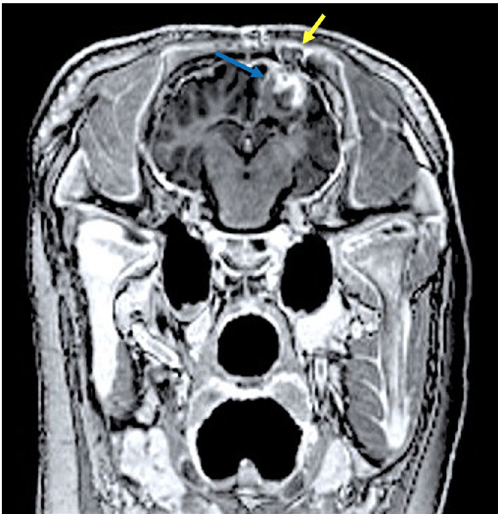
Figure 4. Postoperative T1 weighted MRI with contrast inversion prepared gradient echo coronal section of the brain and cryolesion. A large, well-defined lesion (blue arrow) is seen cranial to the right ventricle with a thin contrast enhancement peripherally. From the burr hole and into the cryolesion, a wedge-shaped lesion (yellow arrow) is seen, which is compatible with the spongostan used to close after the procedure.